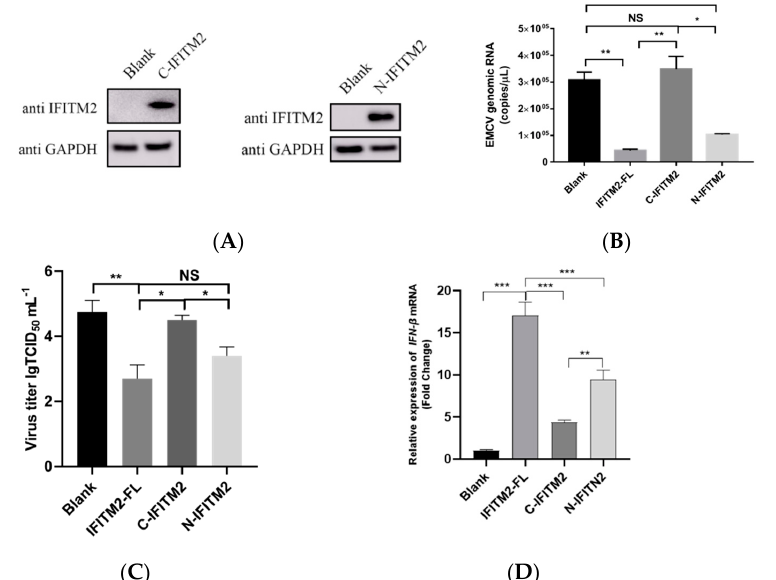
Figure 9. ( A ) HEK293 cells were cultured in 6 − well plates when cells grew to a dense